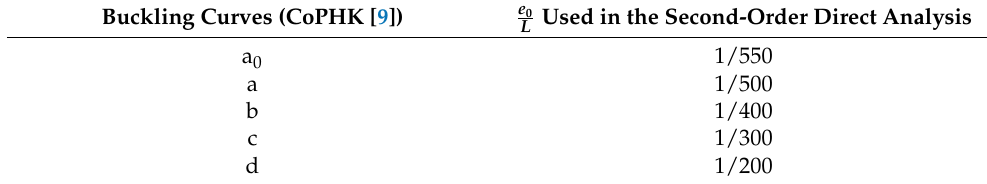
Table 1. Values of member initial bow imperfection used in design.